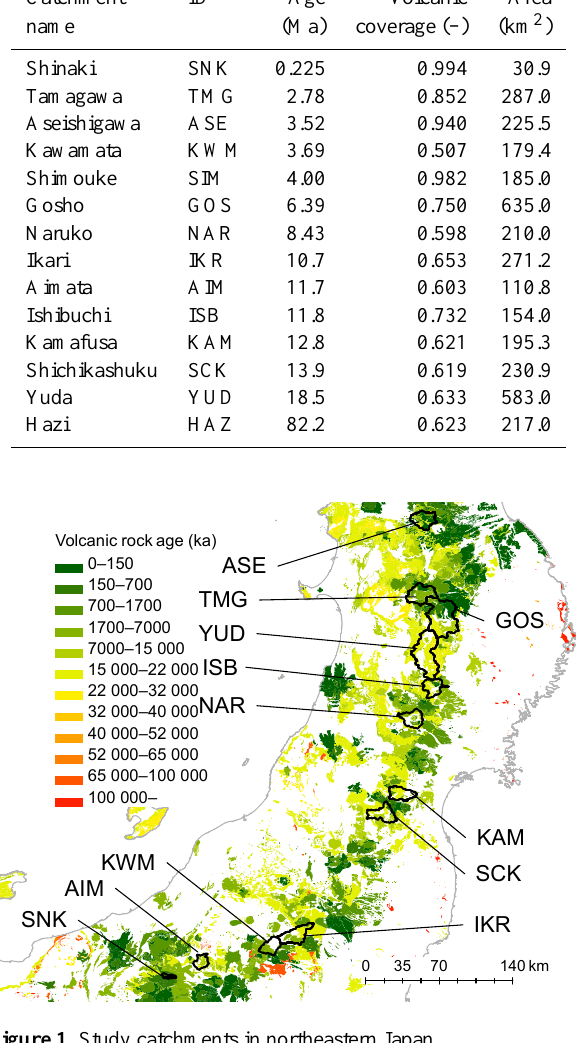
Figure 1. Study catchments in northeastern